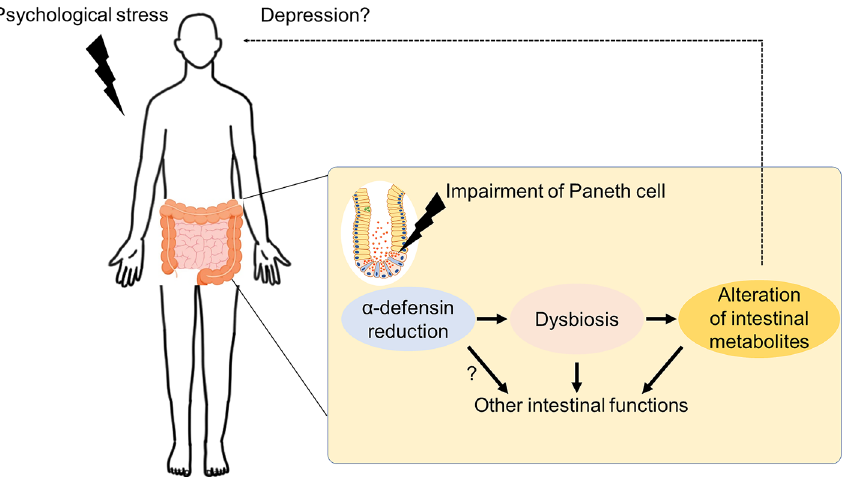
Figure 6. Hypothesis of a novel mechanism based on α-defensin in the CSDS model. Psychological stress reduces α-defensin produced by Paneth cells in the gut and disrupts the homeostasis of intestinal metabolite composition via dysbiosis. These are normalized by α-defensin administration. Thus, disruption of metabolite homeostasis may affect brain function and lead to the development or exacerbation of depression. However, the direct effects on the brain have not been demonstrated, and are shown as dotted